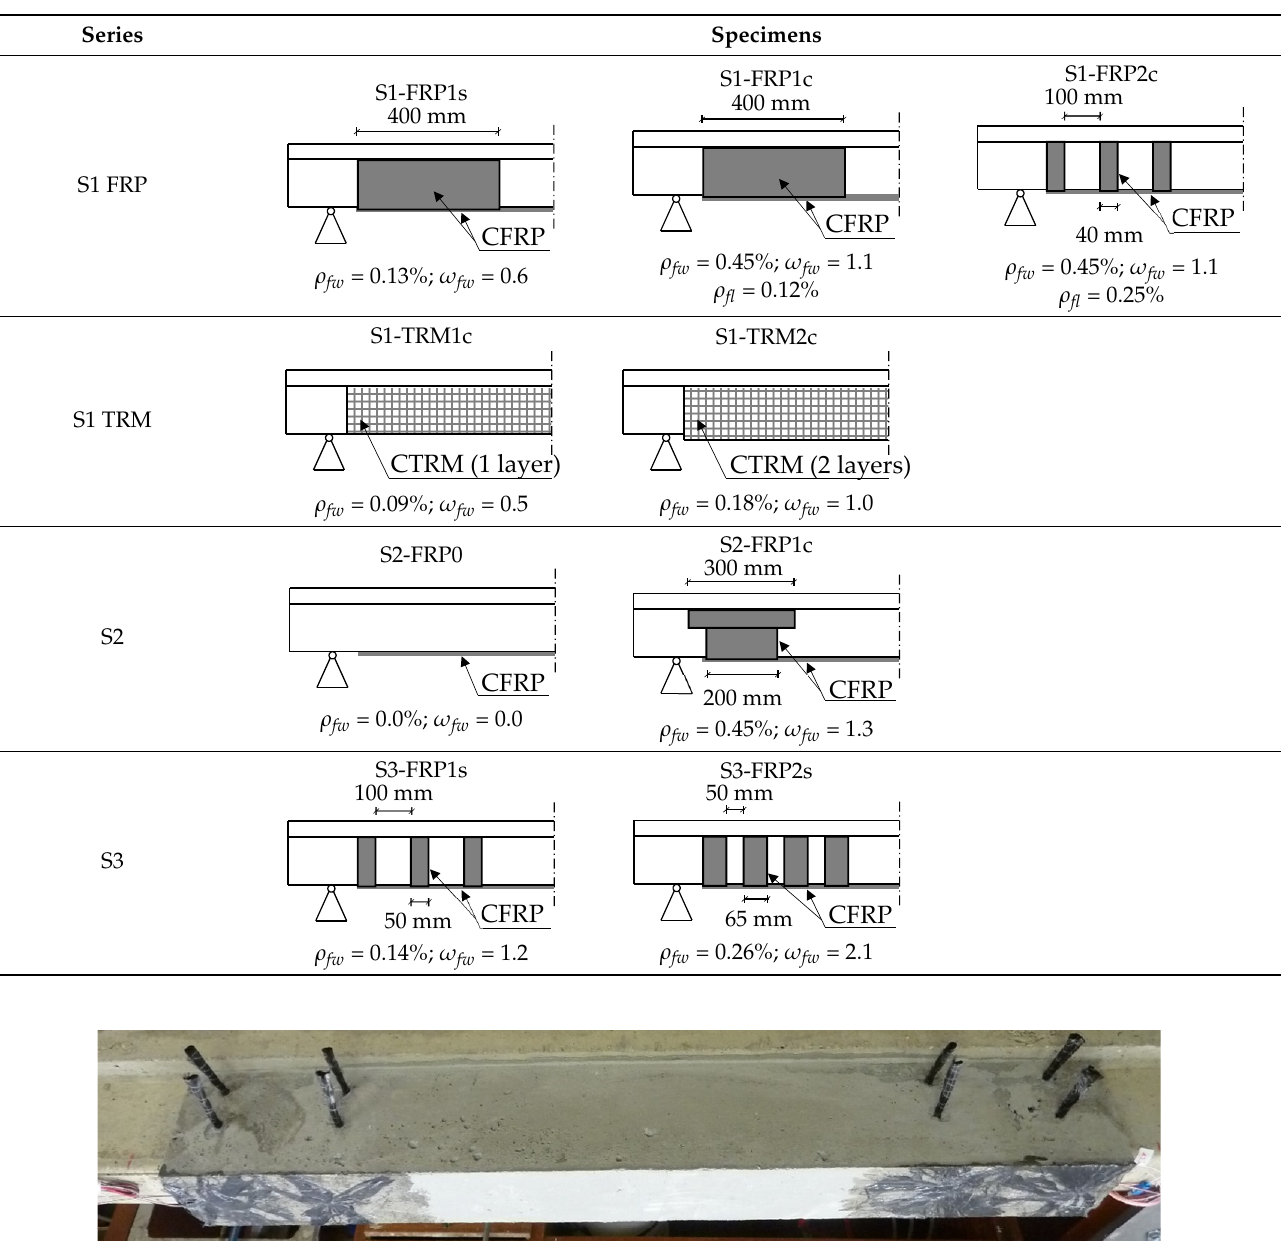
Table 4. Retrofit detailing for all specimens.